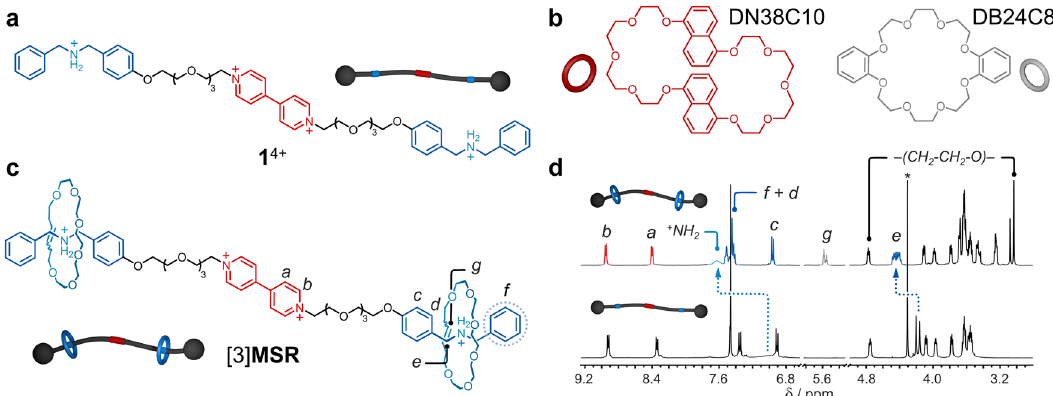
Fig. 2 NMR data for [3]MSR and the axle. Chemical structures and schematic representations of a , b the employed molecular components and c the assembled metastable [3]rotaxane [3] MSR . d Partial 1 H NMR spectra (CD 3 CN, 400 MHz) of [3] MSR (top) and 1 4 + (bottom) prepared at 3.5 × 10 -3 M. *Denotes MeNO 2 .